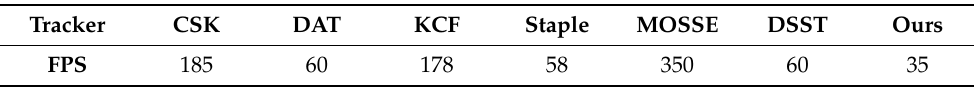
Table 3. Comparing the Seven trackers on the nine sequences, the average time consumption of every tracker is shown in terms of